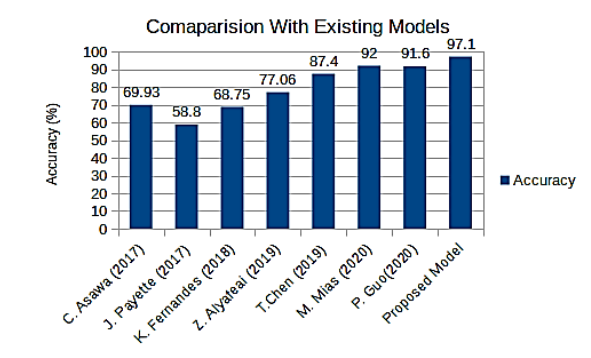
Figure 10. Comparison